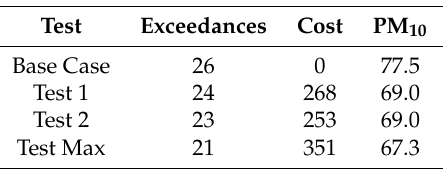
Table 3. Results